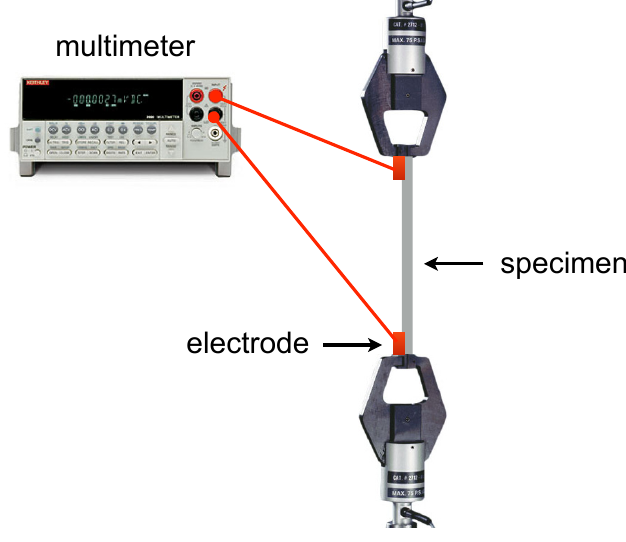
Figure 25. Schematic of tension test setup. Adapted from Park et al. [171].